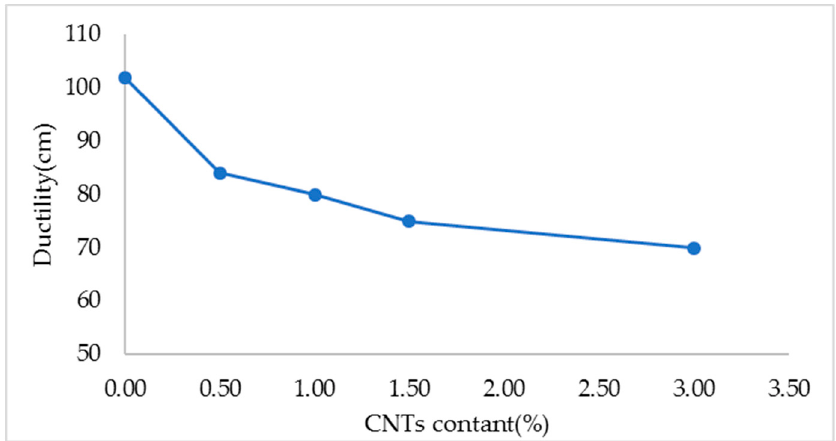
Figure 10. Ductility of bitumen with different contents of CNTs.